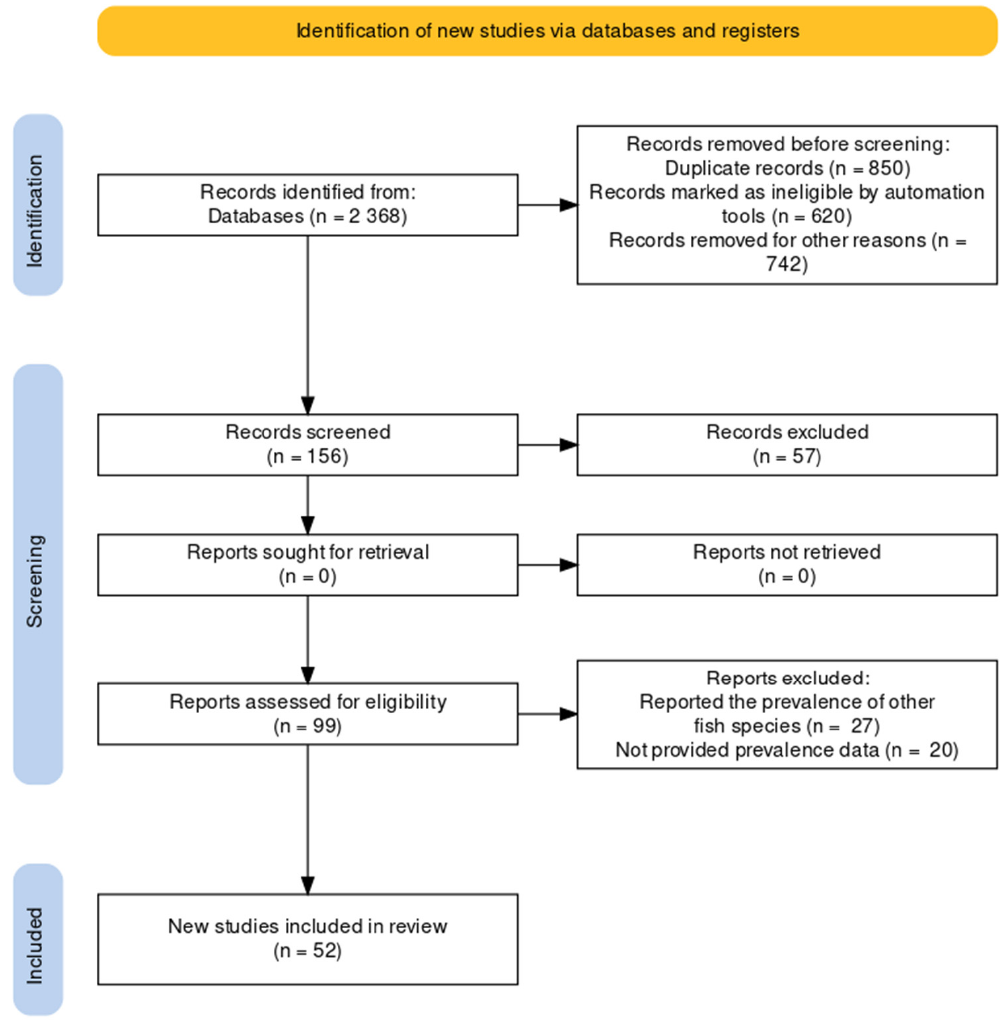
Figure 1. Flow diagram describing the paper selection process according to PRISMA guidelines.